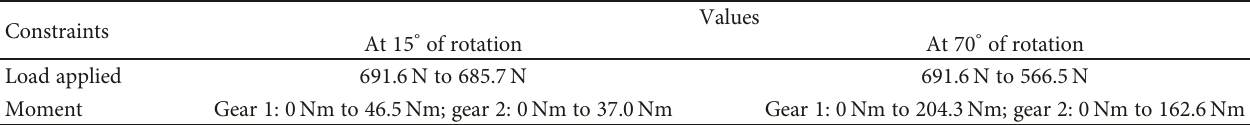
Figure 7: (a) Model of gear-based knee joint. (b) Solid mesh of the model. Table 5: Boundary conditions of the knee joint FE